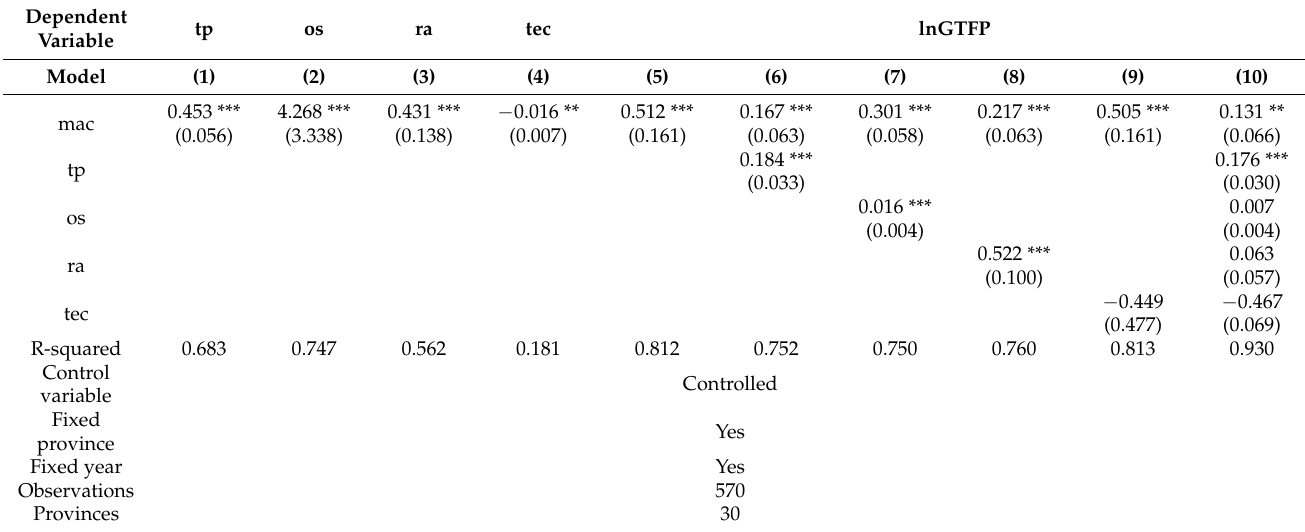
Table 3. Results of the transmission mechanism of mechanization to planting